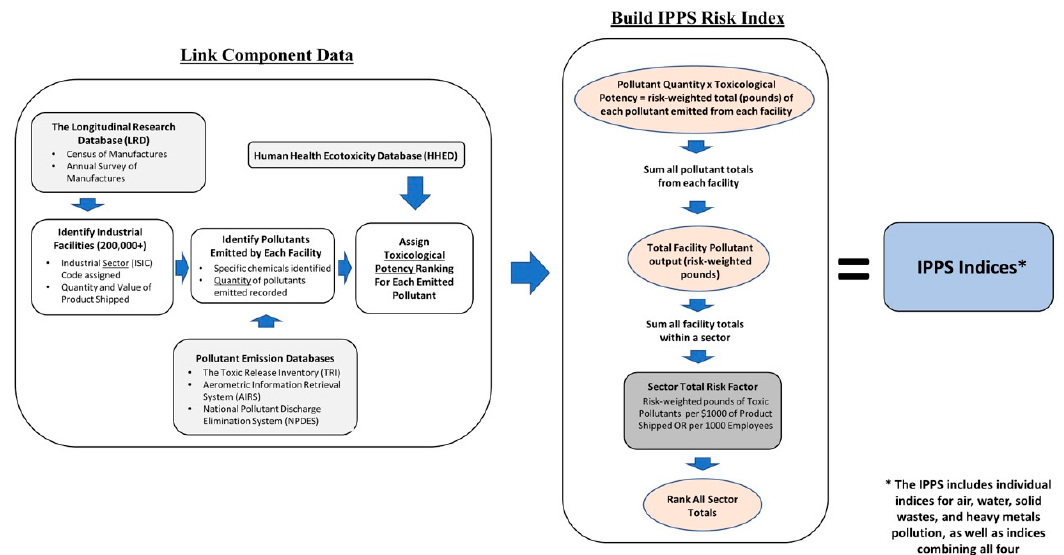
Figure 4. Industrial Pollution Projections System (IPPS) workflow illustration by author, modified after [41]